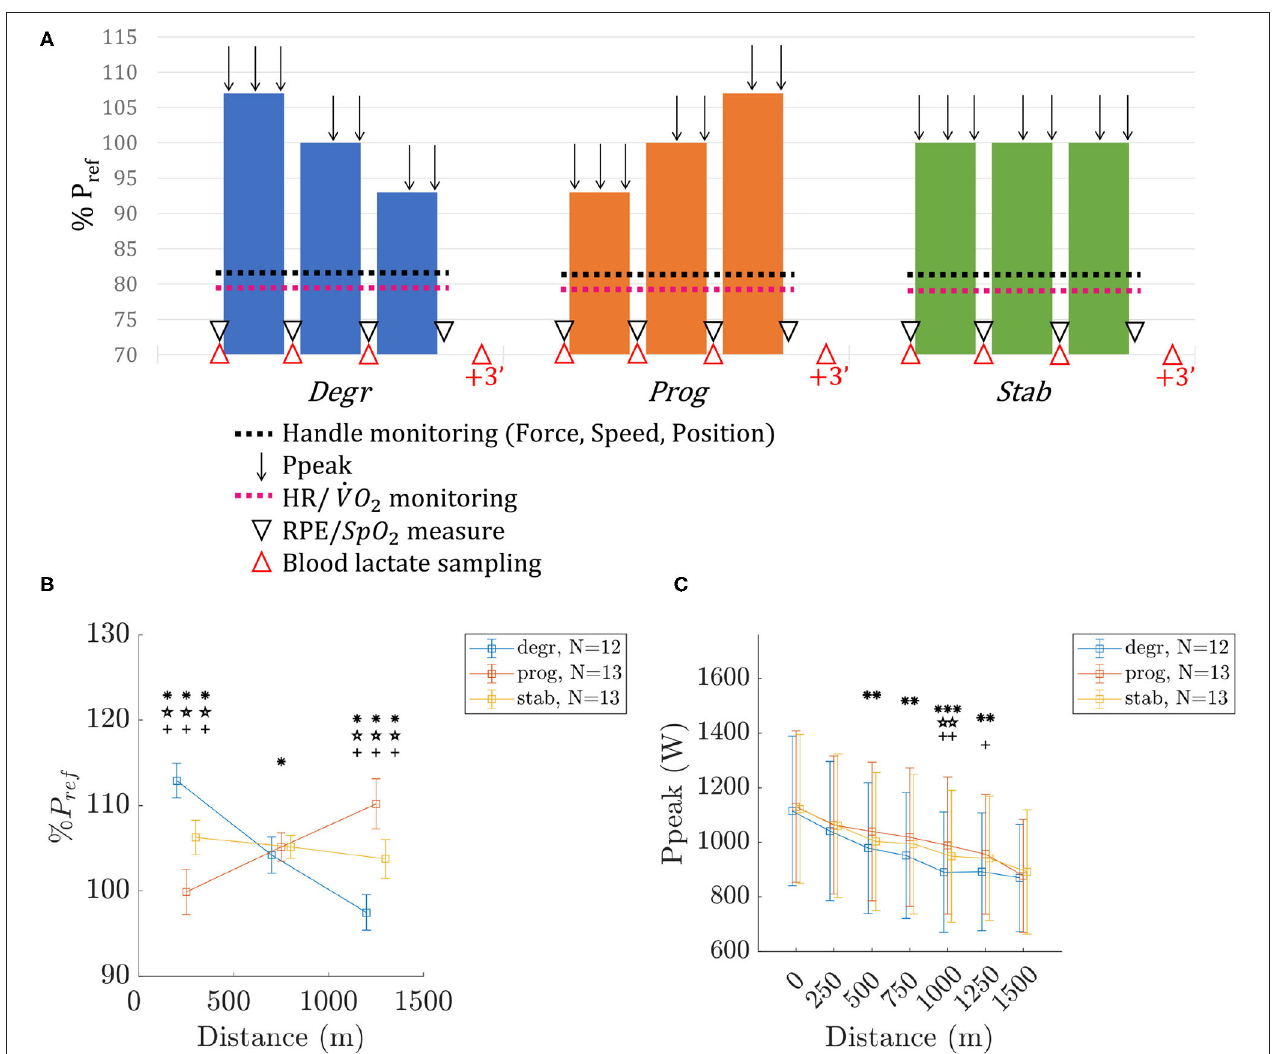
FIGURE 1 | Protocol design (A) , mean power on each 500 m (B) and Ppeak time-courses (C) . Values are mean ± SD. The symbols ∗ , ⋆ , and + indicate a significant difference between degr - prog , prog - stab , and stab - degr , respectively. The number of symbols (one, two, or three) indicate the p -value ( < 0.05, < 0.01, and < 0.001,